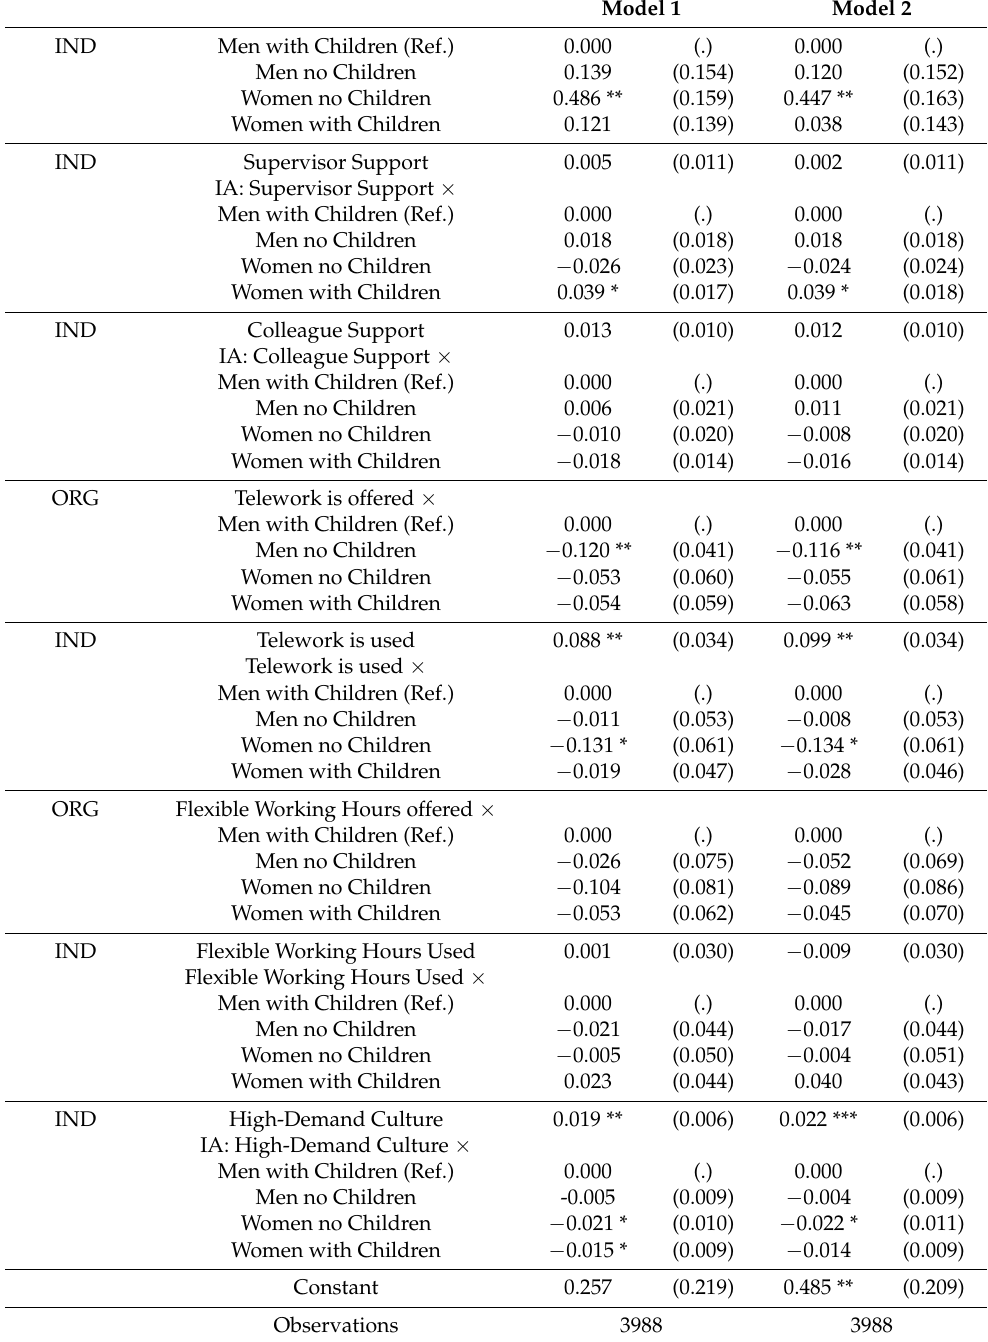
Table 5. Gender Gap in Claims-Making and Family-Friendliness of the Work Environment (results of linear fixed-effects